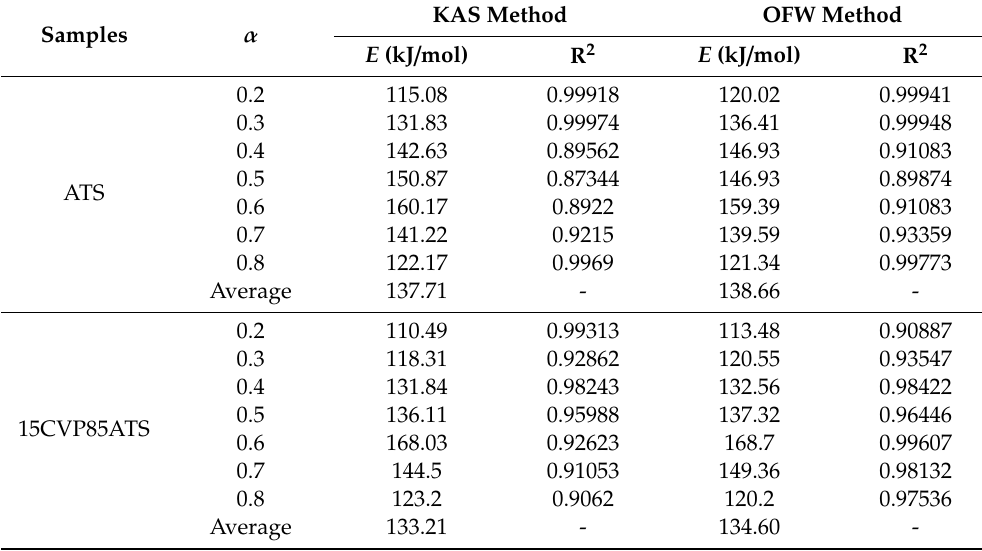
Table A1. The E values at β = 20, 30, and 40 ◦ C / min by KAS and